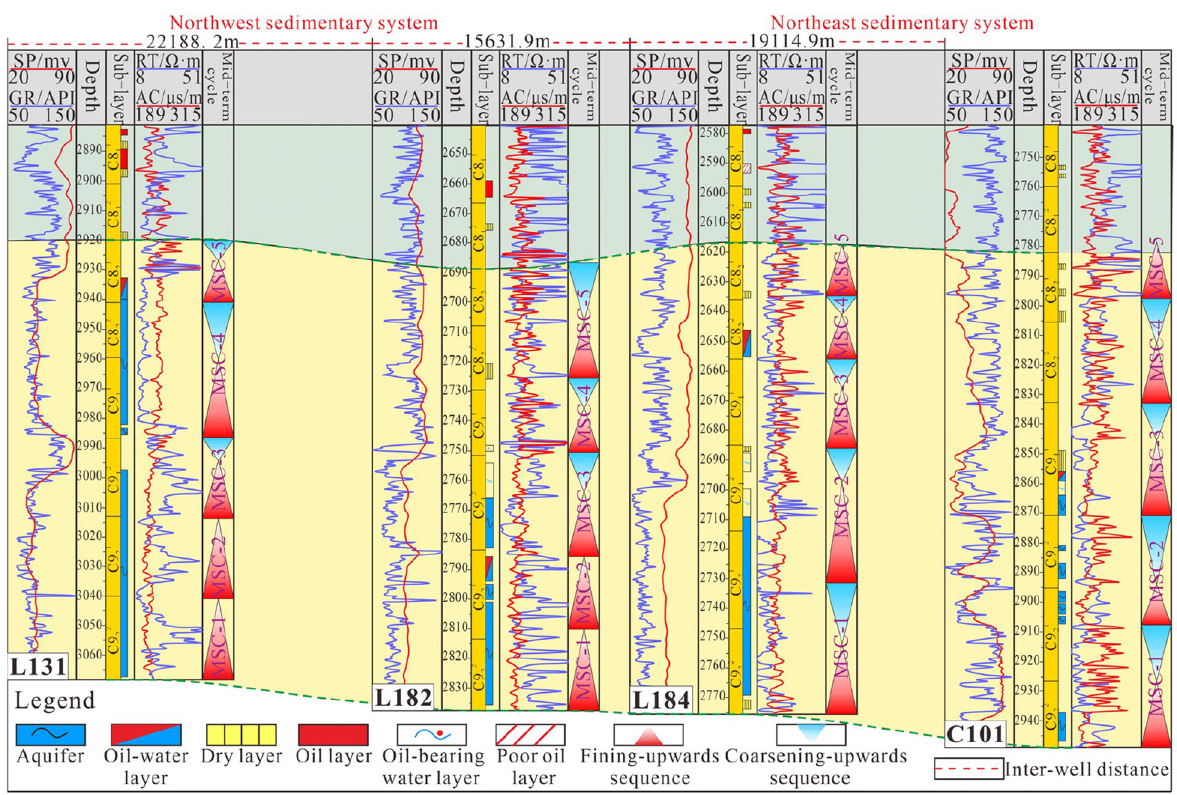
Figure 8. Identification and division of medium-term cycles in typical cored wells (Note: SP, GR, RT and AC are abbreviations of logging curve names. SP represents the spontaneous potential curve, GR represents the natural gamma curve, RT represents the resistivity curve, and AC represents the interval transit time curve. The medium-term cycles are abbreviated